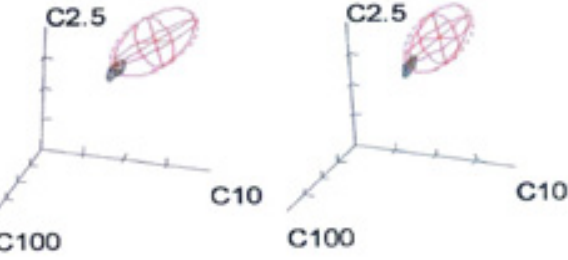
Figure 9. A comparison of surfaces of constant probability density (95% confidence ellipsoids) for contrast visual acuities for the eyes of diabetics 25, 26 , firstly without DR and DME (black ellipsoid) and secondly with DME (red ellipsoid). The origin is LogMAR and tick intervals of 0.25 LogMAR apply. Perhaps, not too unexpectedly, CVA was more variable and generally worse in the eyes with DME 25, 26 ; that is, in comparison with the black ellipsoid the red ellipsoid has a greater volume and is shifted further away from the